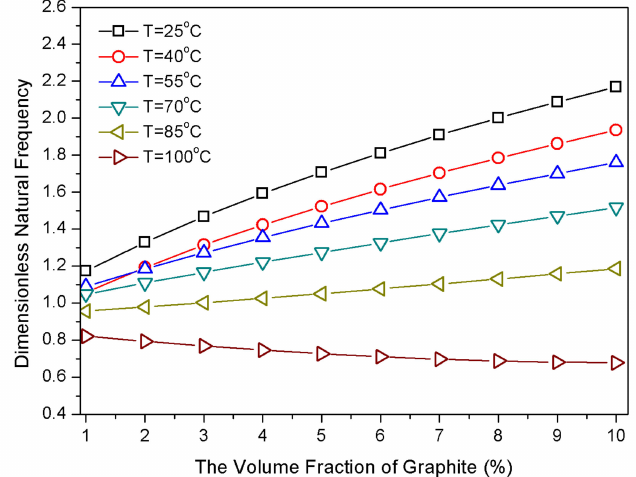
Figure 7. Dimensionless natural frequencies vs. the graphite volume fraction subjected to di ff erent